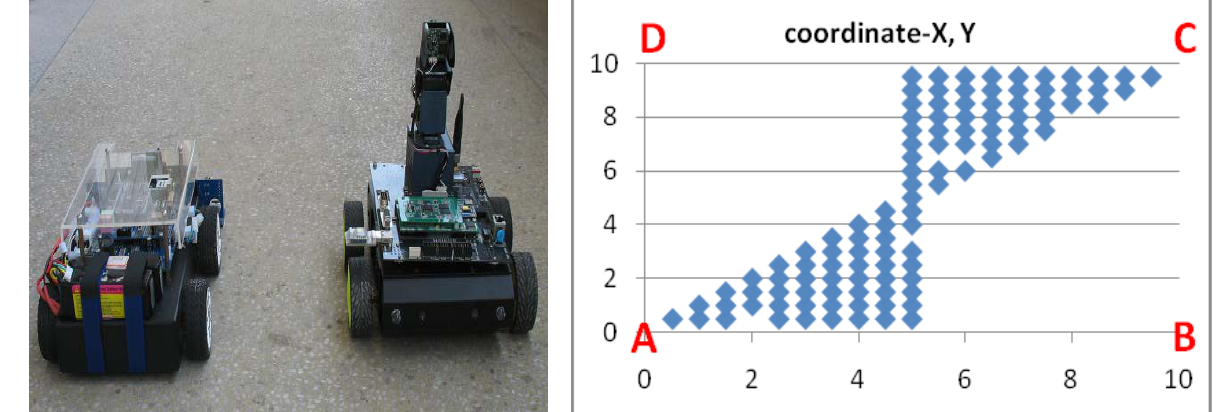
Figure 1. Intelligent vehicle with wireless sensors (Wan, Suo, Yan & Liu, 2011)